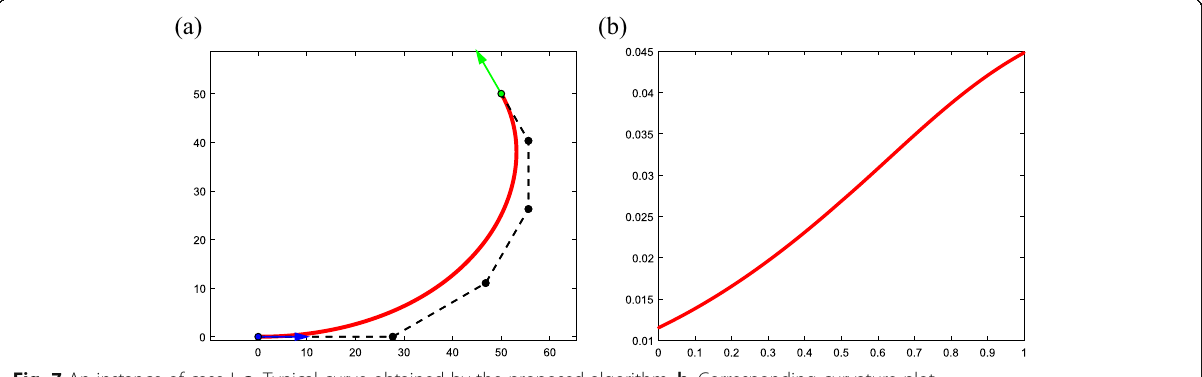
Fig. 7 An instance of case I. a : Typical curve obtained by the proposed algorithm; b : Corresponding curvature